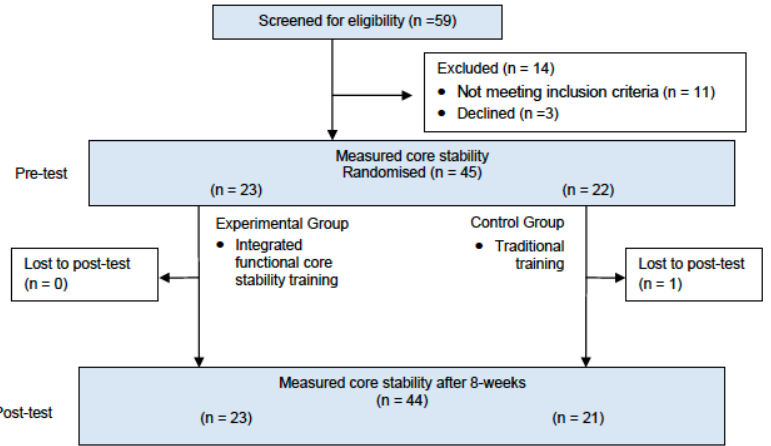
Figure 1. Flowchart.